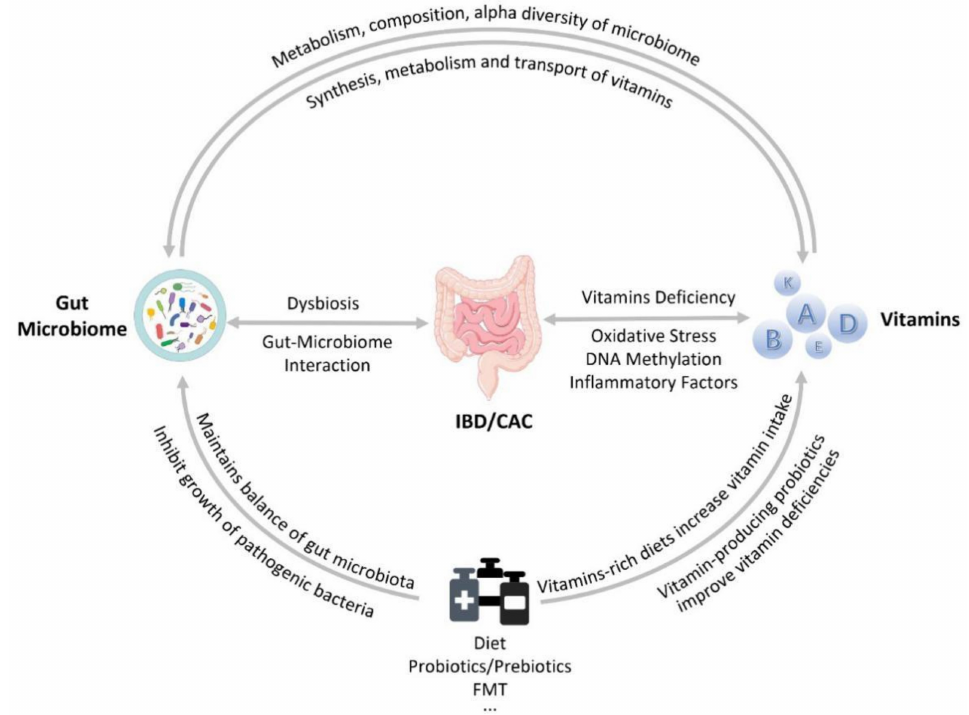
Figure 2. The interaction mechanism of vitamins and gut microbiota in inflammatory bowel disease (IBD) and colitis-associated colorectal cancer (CAC). Fecal microbiota transplantation, FMT, is defined as the transplantation of functional flora in the feces of healthy people into the gastrointestinal tract of patients to rebuild new intestinal flora and achieve the treatment of intestinal and extra- intestinal